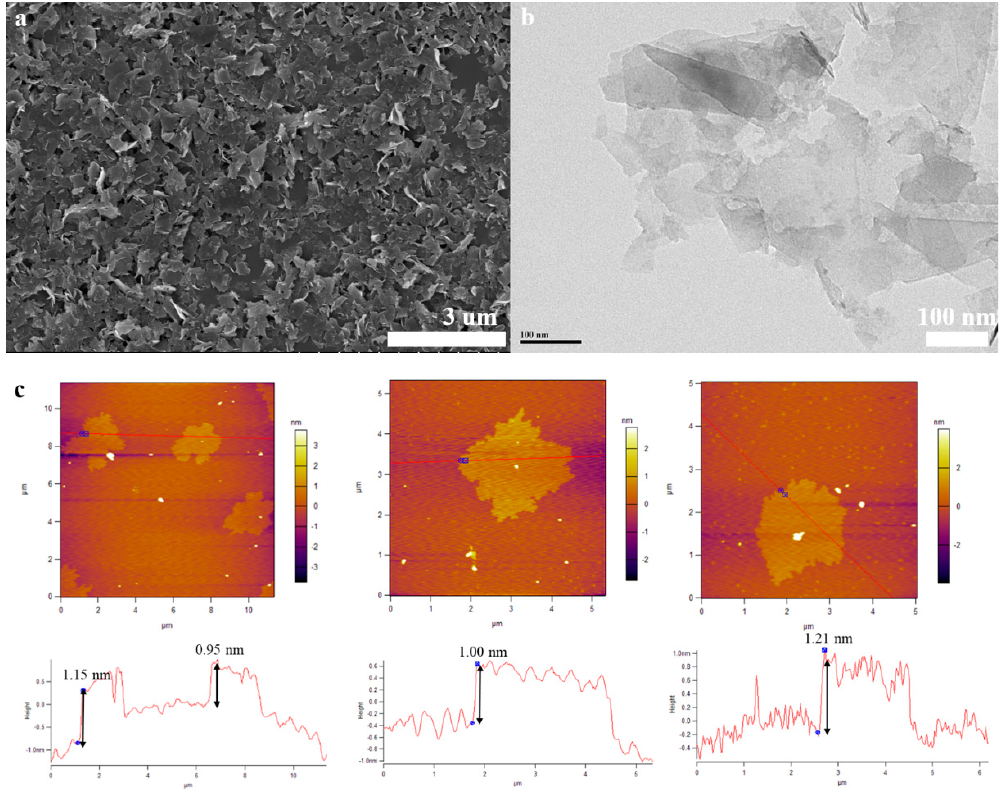
Figure 2. ( a ): SEM image of the FLG nanosheets, ( b ): TEM image of the FLG nanosheets, ( c ): AFM Figure 2. a: SEM image of the FLG nanosheets, b: TEM image of the FLG nanosheets, c: AFM image image of the FLG of the FLG nanosheets.